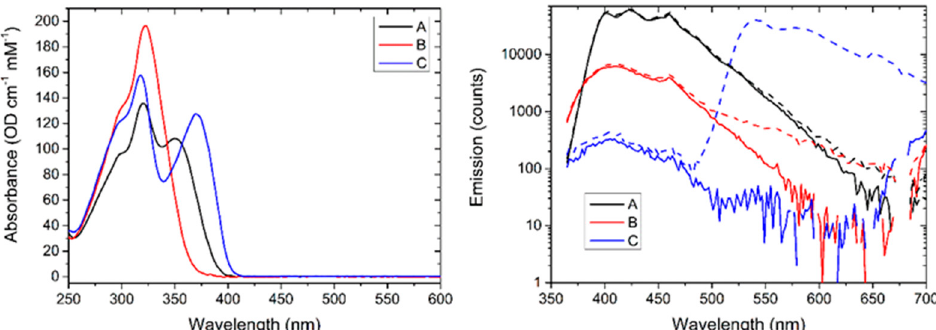
Figure 2. ( Left Panel ) Absorbance spectra of molecules “A” (black), “B” (red), and “C” (blue). ( Right Panel ) Emission spectra of molecules “A” (black), “B” (red), and “C” (blue). The dashed lines are after oxygen removal through argon bubbling. The excitation wavelength was 337 nm.